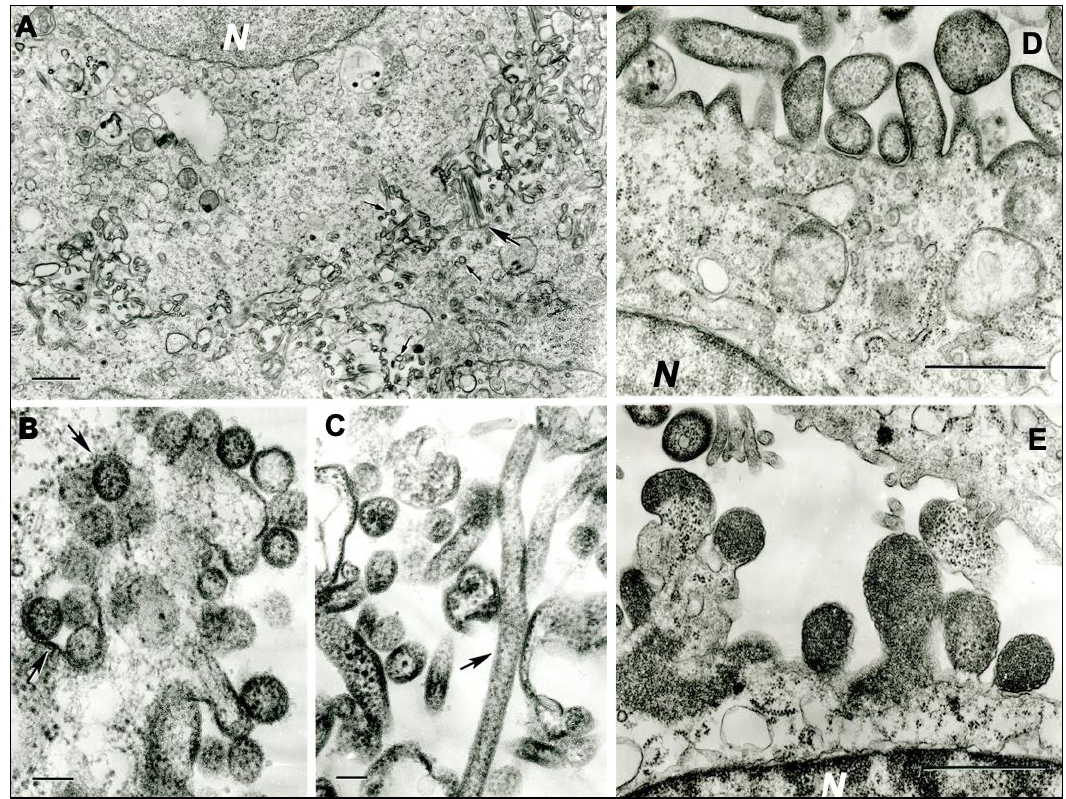
Figure 1. Ultrastructure of MCRV (DO 159) in infected C6/36 cells, and SJCV (DO 200) in infected Vero E6 cells. ( a ) Multiple virus particles of MCRV forming at the cell surfaces of adjacent cells. N- cell nucleus. The large arrow shows two very long filamentous virions; small arrows show spherical virions. Bar = 1 µm. ( b ) Spherical virions of MCRV 130 – 150 nm in diameter at the cell surface. Arrows show cross-sections of the invaginations of the cell surface containing virions. Bar = 100 nm. ( c ) Virions of MCRV in extracellular space, a very long one (arrow) and pleomorphic. Bar = 100 nm. ( d ) and ( e ) Virions of SJCV forming at the surface of infected Vero E6 cells. N = fragments of cell nuclei. Bar = 1 µm.